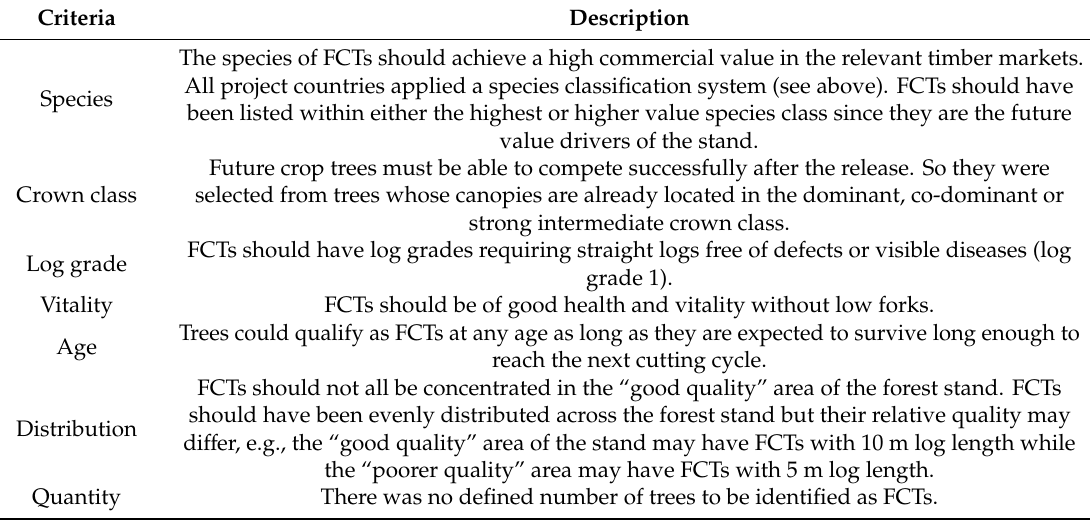
Table 1. Characteristics of future crop trees (FCTs) ([35], modified).